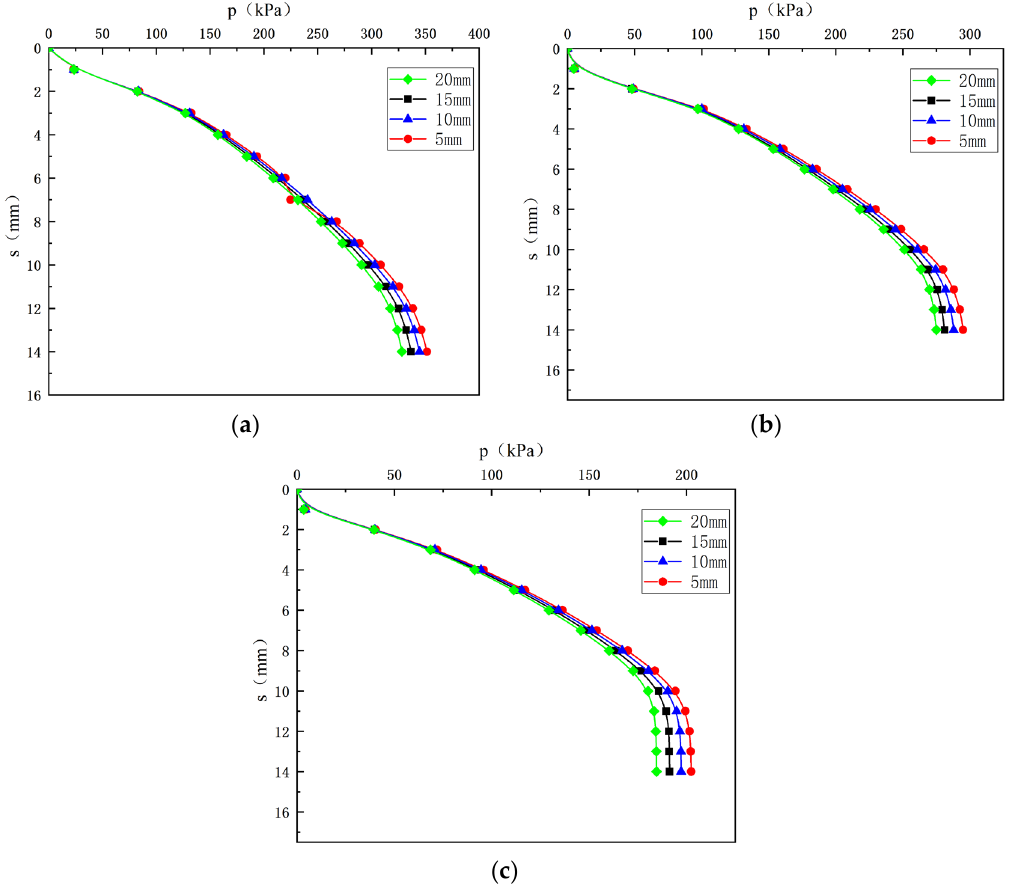
Figure 11. The p–s curves under different water level fluctuation ranges: ( a ) 50 mm water level, ( b ) 100 mm water level and ( c ) 150 mm water level.